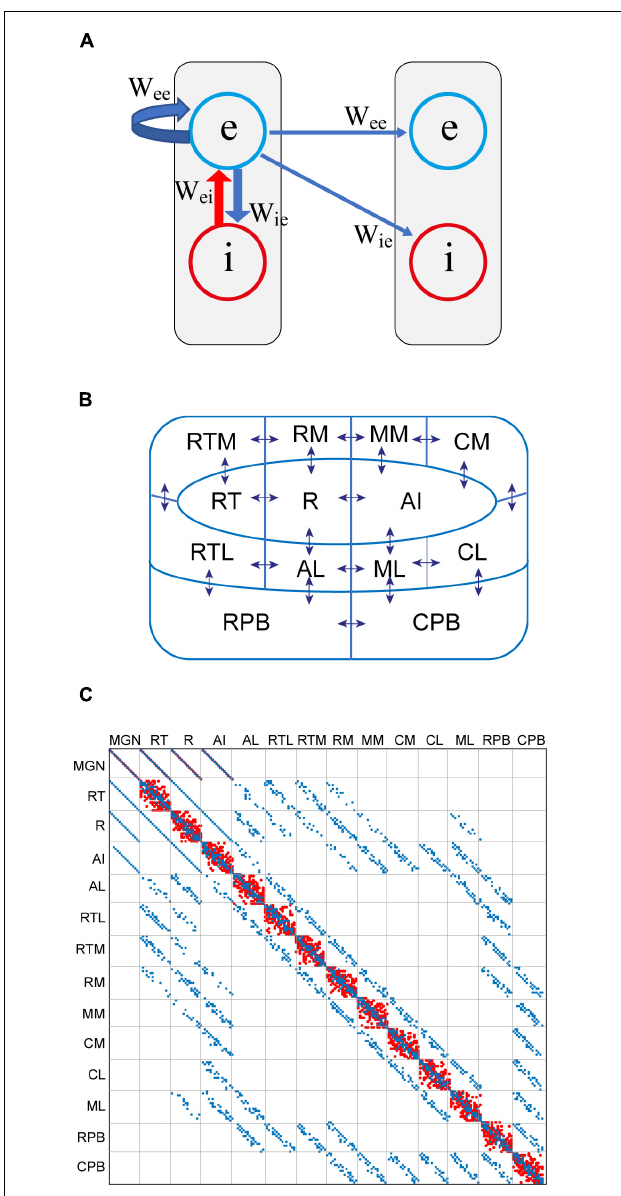
FIGURE 1 | A computational model of auditory cortex as a modern version of the adaptation model. (A) The basic functional unit of the model is the cortical column. This comprises a lumped description of the excitatory (e) and inhibitory (i) neuron populations. The e-population connects back to itself via feedback connections described in the weight matrix W ee . It also excites the excitatory populations of other columns. Lateral inhibition occurs through the e-population driving the i-population of neighbouring columns. (B) There are 208 cortical columns organised into three core fields (R, RT, AI), eight belt fields (AL, RTL, RTM, RN, MM, CM, CL, ML), and two parabelt fields (RPB, CPB). Neighbouring fields are strongly interconnected, as indicated by the arrows. The connections from RPB to RTM and RM as well as those from CPB to RM, MM, and CM are not shown. Abbreviation key: A – anterior (except for AI, primary auditory cortex), R – rostral, C – caudal, M – medial, L – lateral, T – temporal, PB – parabelt. (C) The weight matrices W ee (blue) and W ie (red) are overlayed. W ie mediates lateral inhibition within each field. Long-range connections are found in W ee only. Feedforward connections are below the diagonal, and feedback connections are above